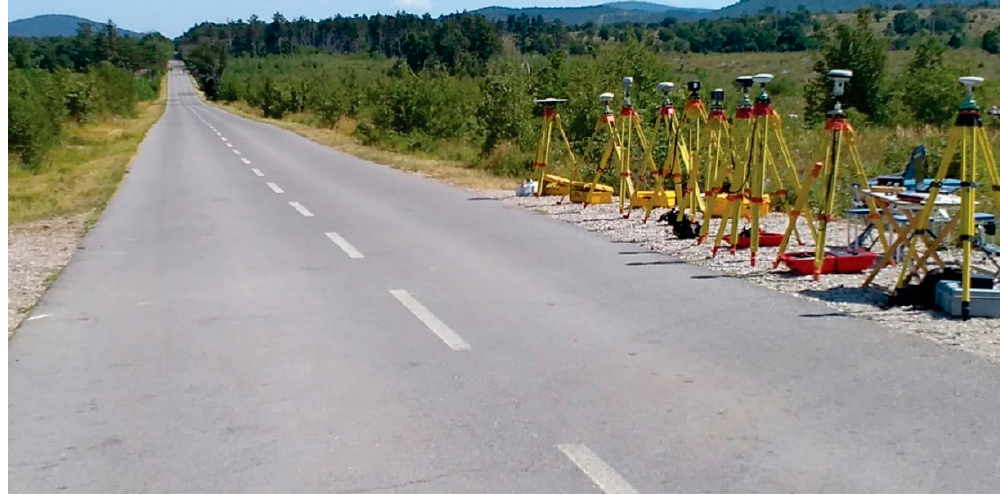
Figure 2. The instrument set up at point B from north-east (left) to south-west (right) at the location (own study).